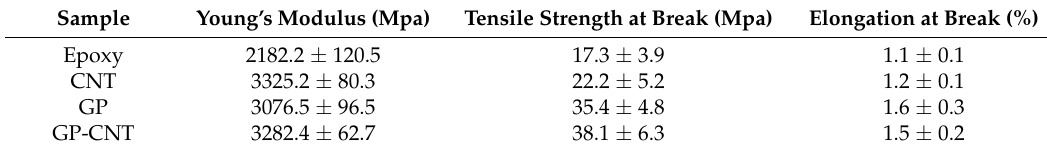
Young’s modulus, tensile strength, and elongation at break for filled and unfilled epoxy